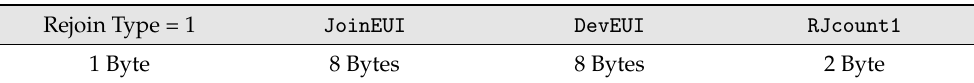
Table 4. Rejoin-Request type 1